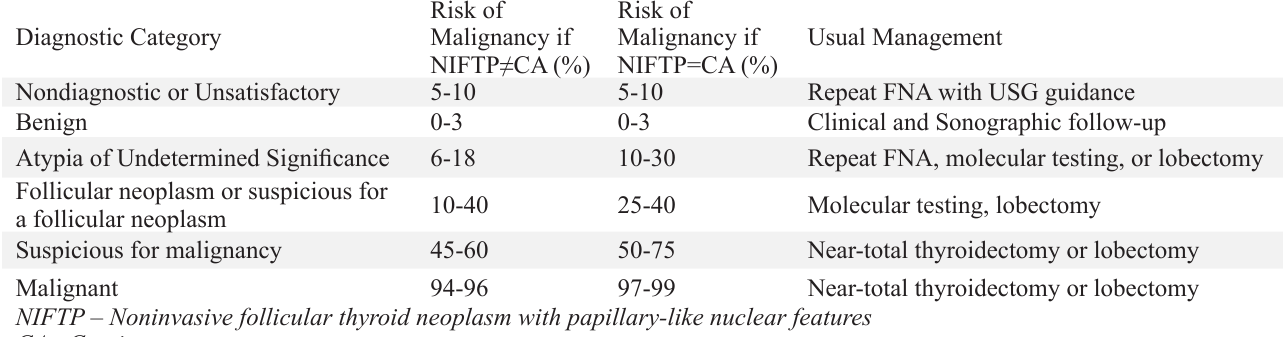
Table 1. Diagnostic Categories with Their Implied Risk of Malignancy, and Recommended Clinical